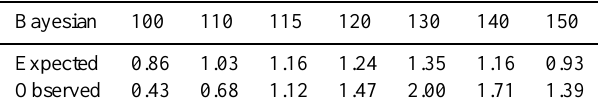
Table 1. Ratios of median expected and observed 95% C.L. limit to the SM cross section for the combined CDF and D0 analyses as a function of the Higgs boson mass.